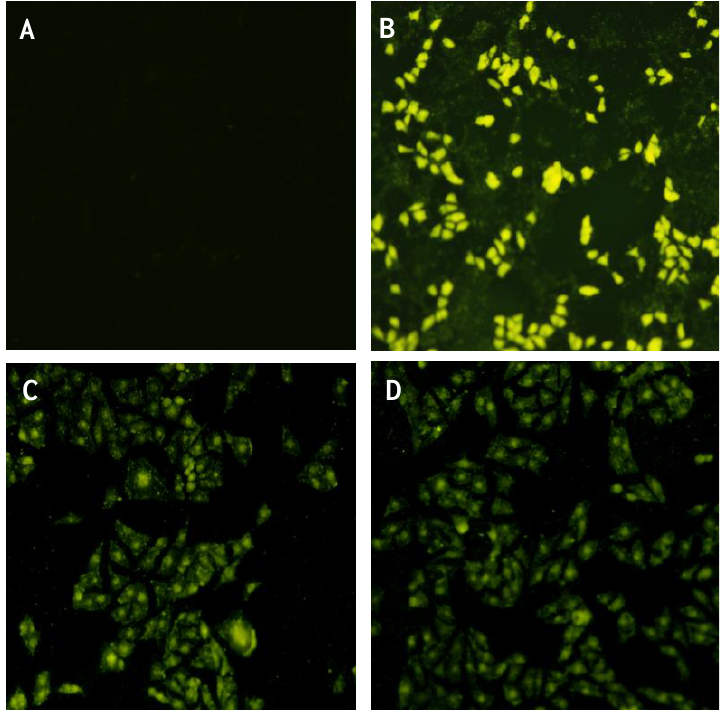
Figure 2. Fluorescent photos of the transfected MARC-145 cells. ( A ) The picture of negative control; ( B ) Green fluorescence images of cells transfected with pEGFP-N1; ( C ) Green fluorescence images of cells transfected with pEGFP-M; and ( D ) Green fluorescence images of cells transfected with pEGFP-IL18-M.